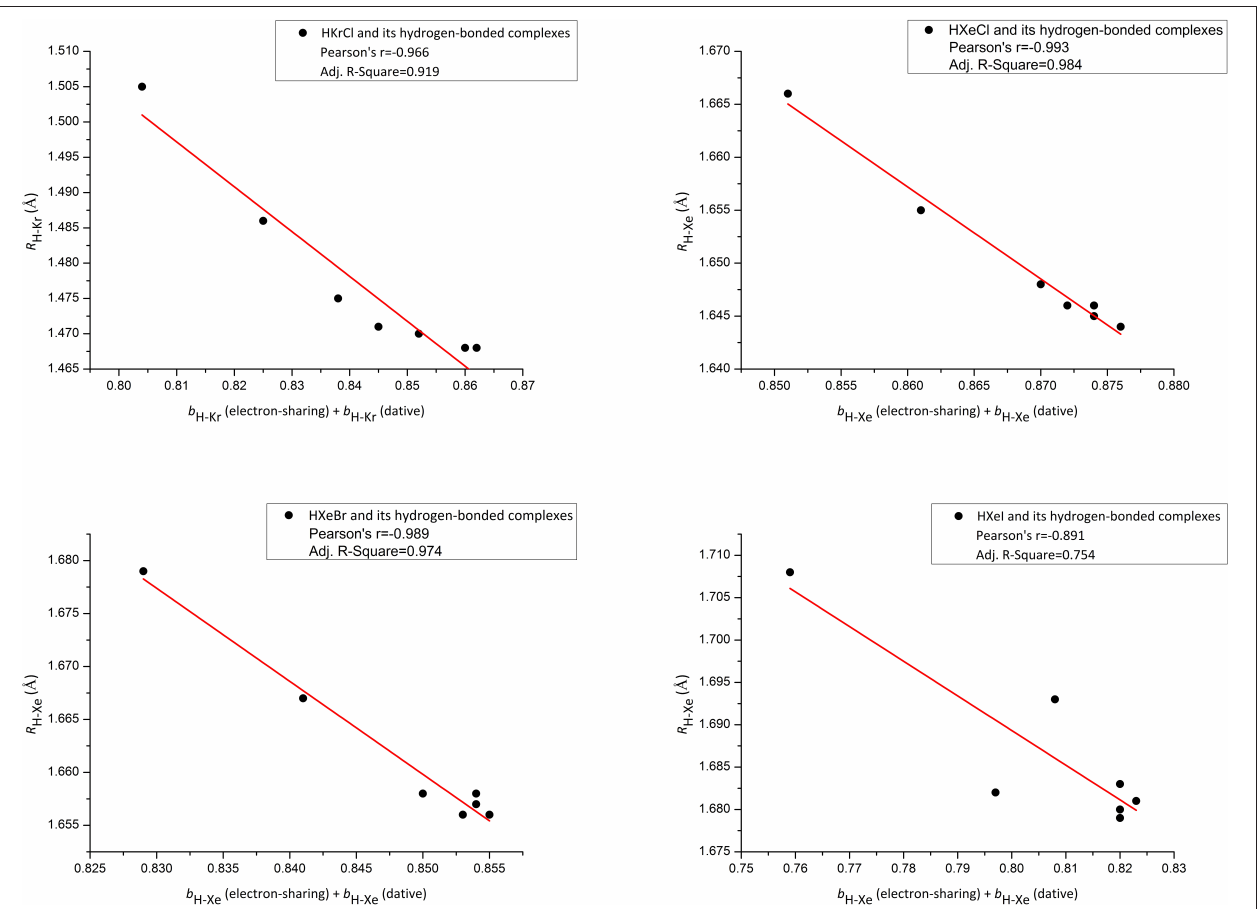
FIGURE 4 | Correlation plot for the sum of electron-sharing and dative H-Xe/Kr bond orders [ b H − Xe / Kr (electron-sharing) + b H − Xe / Kr (dative)]–H-Xe/Kr bond lengths ( R H − Xe / Kr